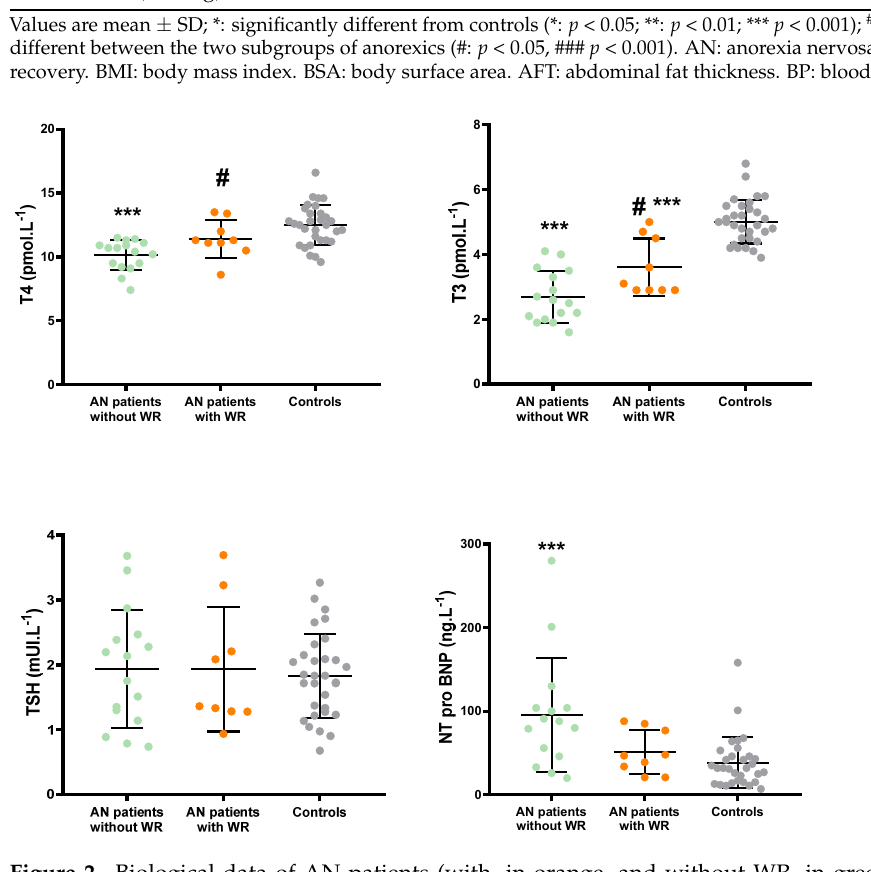
Values are mean ± SD; *: significantly different from controls (*: p < 0.05; **: p < 0.01; *** p < 0.001); # : significantly different between the two subgroups of anorexics (#: p < 0.05, ### p < 0.001). AN: